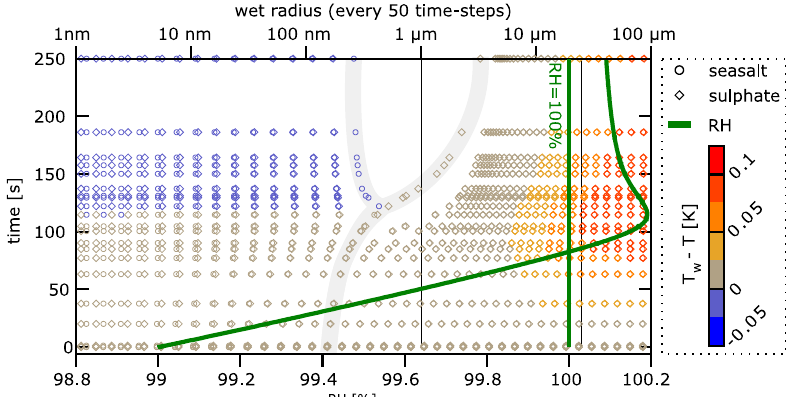
Fig. 2. Evolution of the aerosol spectra (symbols) and the relative humidity (green curve) as calculated in the model run discussed in Sect. 3.1. Wet radii at bin boundaries are drawn every 50 time-steps. Circles and diamonds correspond to sea-salt and sulphate aerosol, respectively. Colour of the symbols indicate the difference between the temperatures of particles and the surrounding air. The two dark-grey vertical lines at 1 and 25µm indicate the region of the spectra used for calculating the moments of the droplet spectrum, as defined by Eq. (25). The thick light-grey bifurcated line in the background is drawn to highlight the two bin boundaries of the same dry radius which undergo markedly different evolution for sulphate and sea-salt aerosol (discussed in the text).